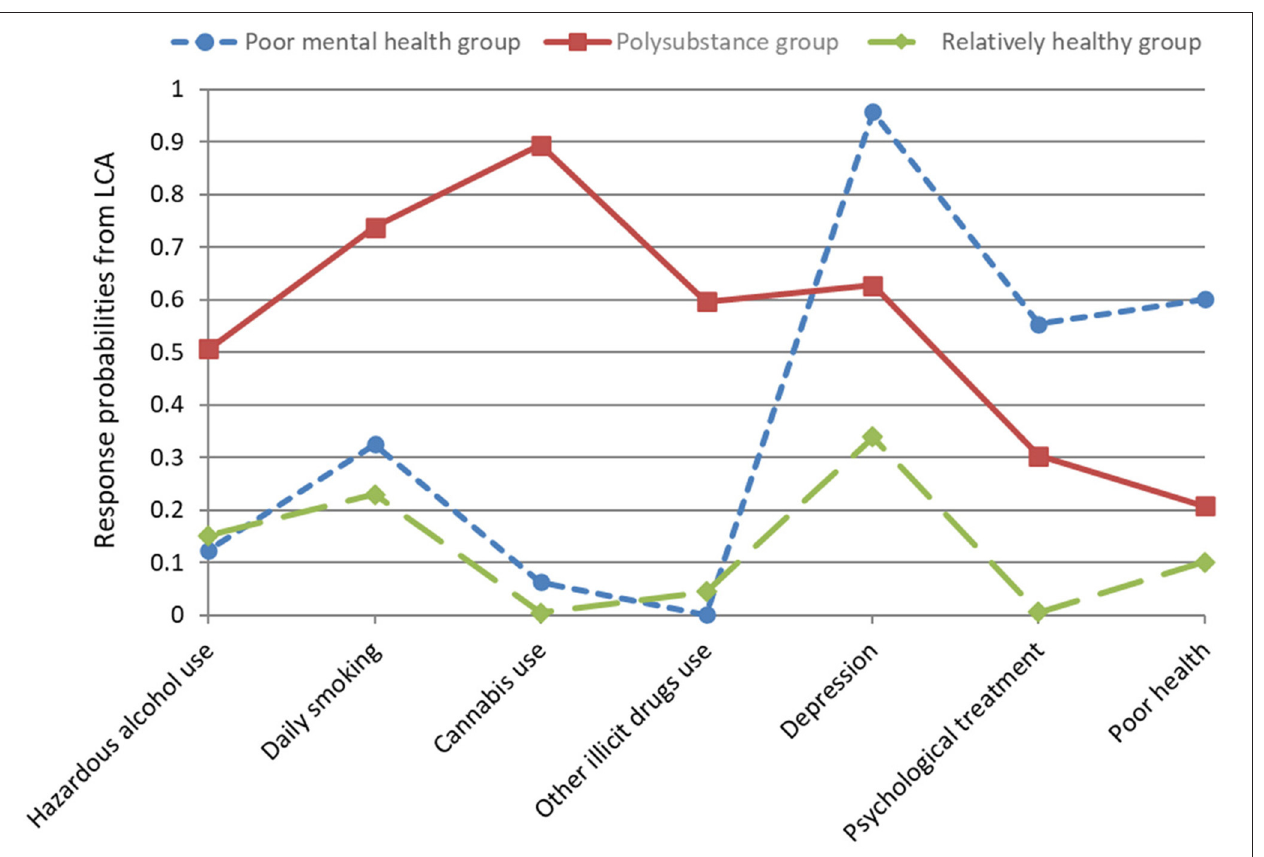
Identifying Subgroups With